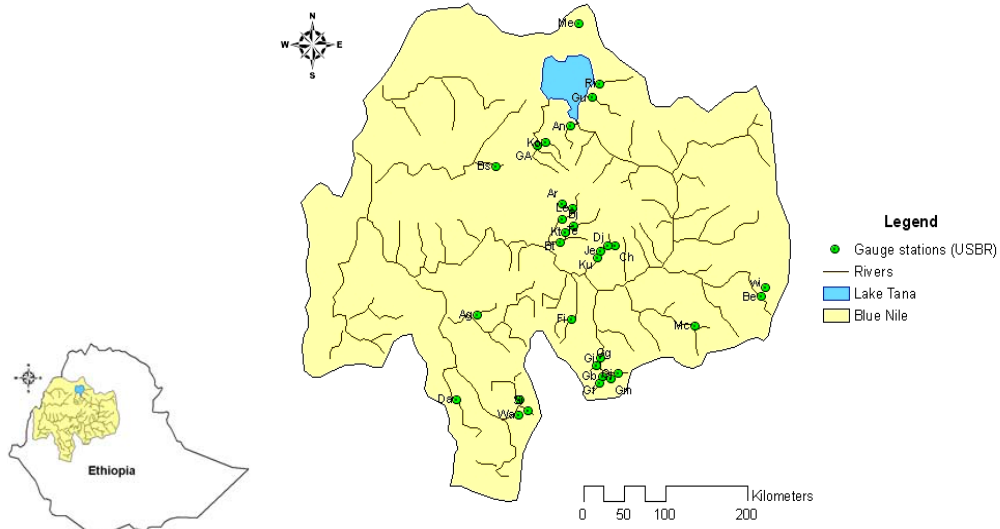
Figure 1. Location of USBR hydrological stations in the Blue Nile Basin included in this study (32 watersheds). See Table 1 for the watershed names associated with each abbreviation on the map.